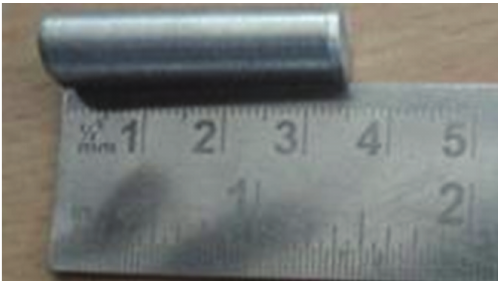
F 2: Typical specimen of AA 6351-�y ash reinforced MMC.